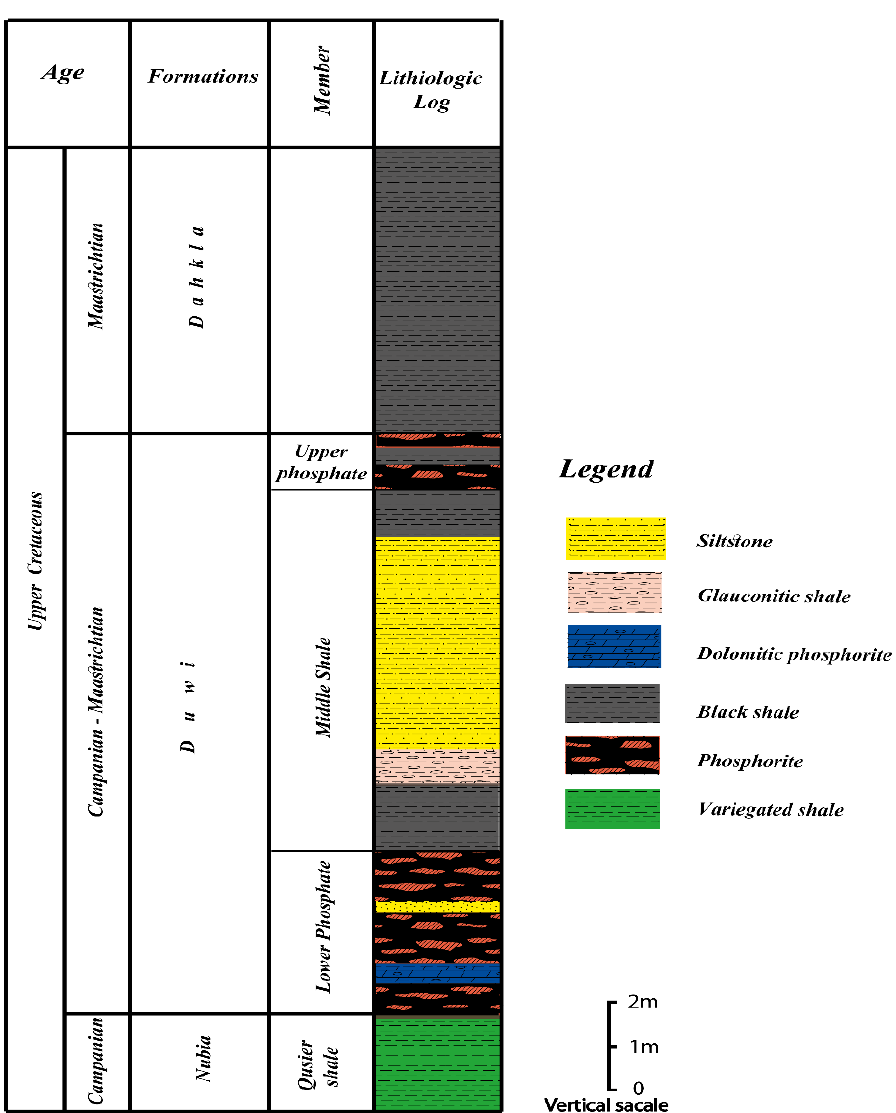
Figure 2. The general lithostratigraphic section of exposed rock units at Gebel Qulu El Sabaya, the southern scarp in the central part of the Abu Tartur Plateau.